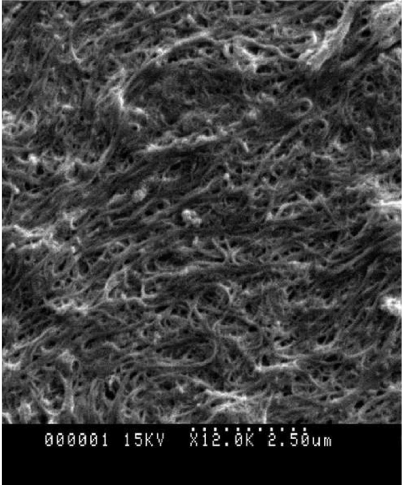
FIG. 2. The SEM image of the film formed from SWNTs synthesized by an arc discharge